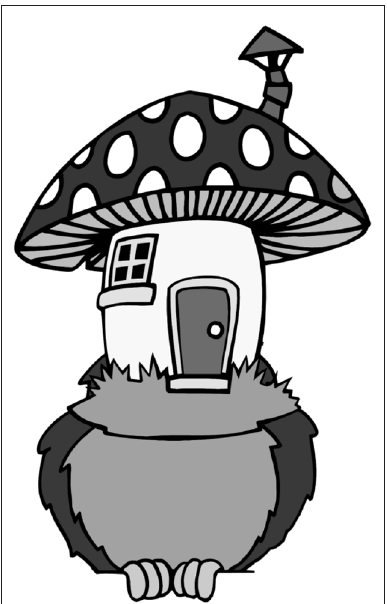
Figure 2: Image from Between Cup and Lip .